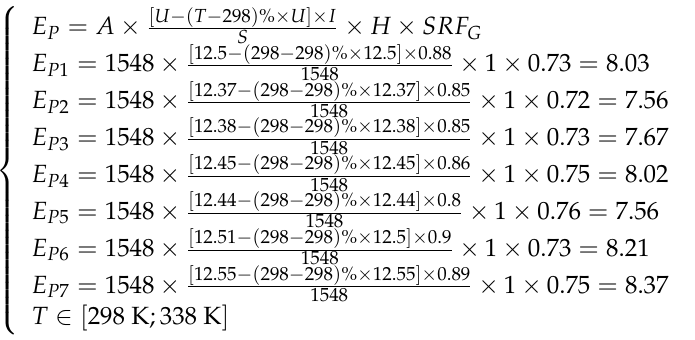
tion during the mostly sunny week is generated in Figure